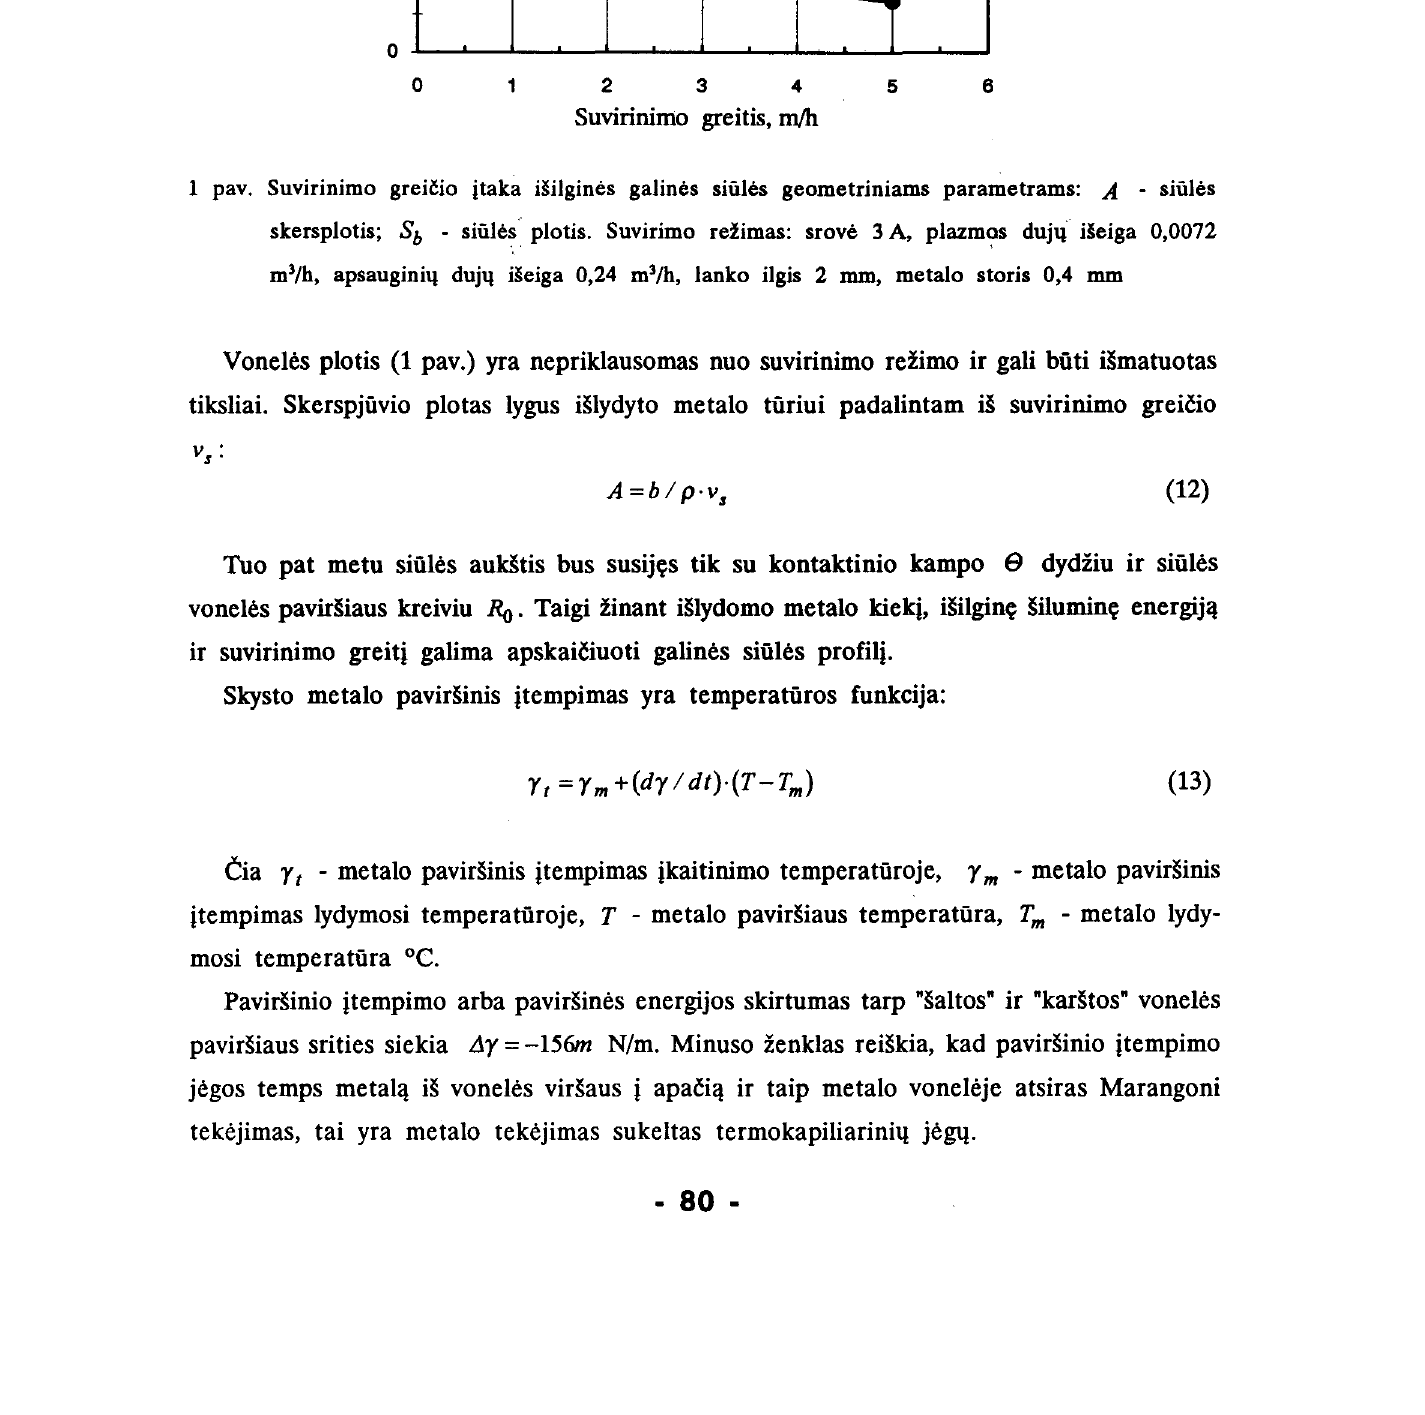
1 pav. Suvirinimo greil!io itaka isilgines galines siiiles geometriniams parametrams: A - siiiles skersplotis; Sb - siiiles plotis. Suvirimo refimas: srove 3 A, plazmas dujli iseiga